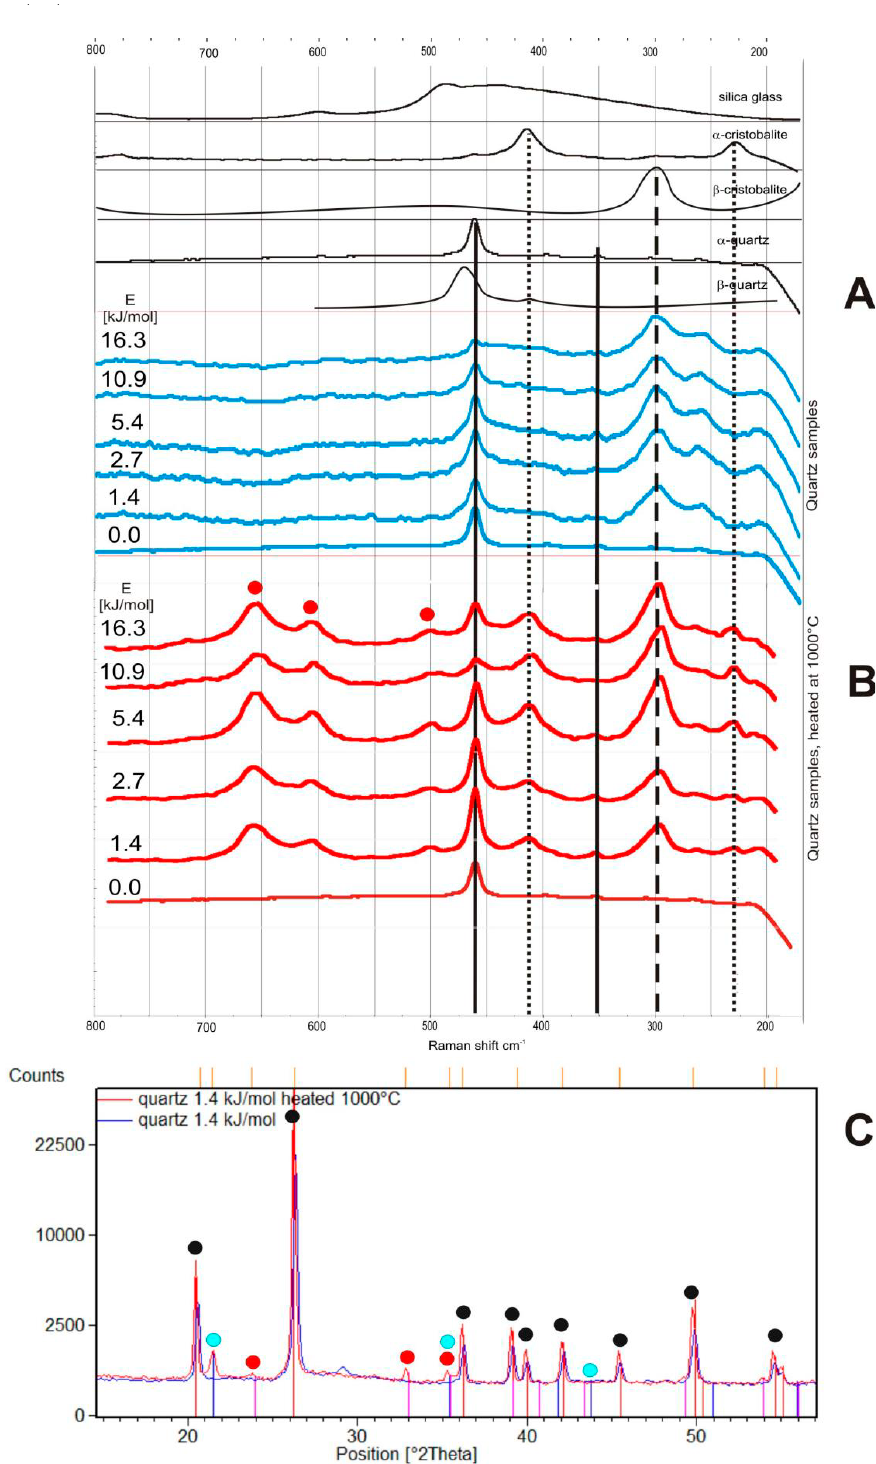
Figure 2. ( A,B ) Raman spectra of the quartz samples vs. spectra of α -quartz, β -quartz, α -cristobalite, β -cristobalite, and vitreous silica. ( A ) Raman Spectra of quartz after milling; ( B ) Raman Spectra of quartz samples after milling and heating at 1000 °C. ( C ) X-ray diffraction spectra of quartz samples, after stress at 1.4 kJ / mol and after annealing; black = α -quartz, blue = β -cristobalite and red = hematite